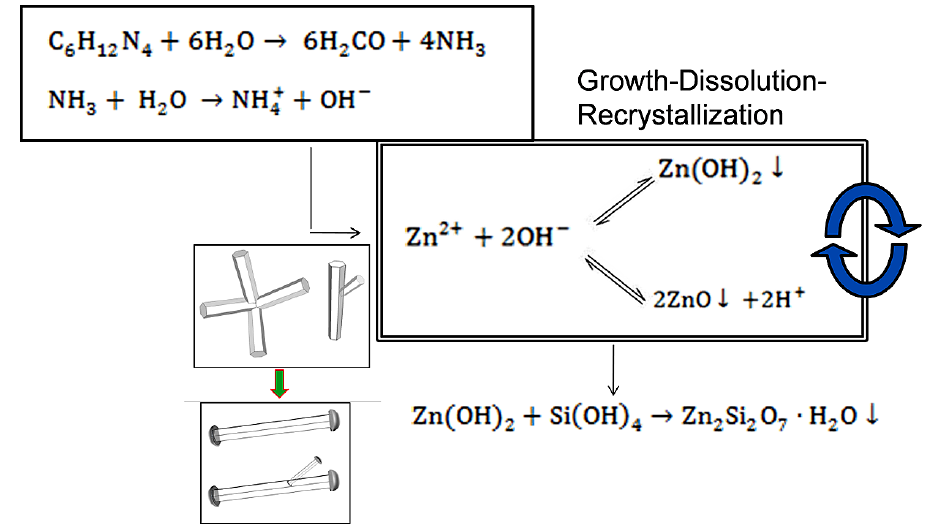
Figure 6. Schematic diagram showing the reaction mechanism of generation of ZnO microstructures generated by microwave-assisted